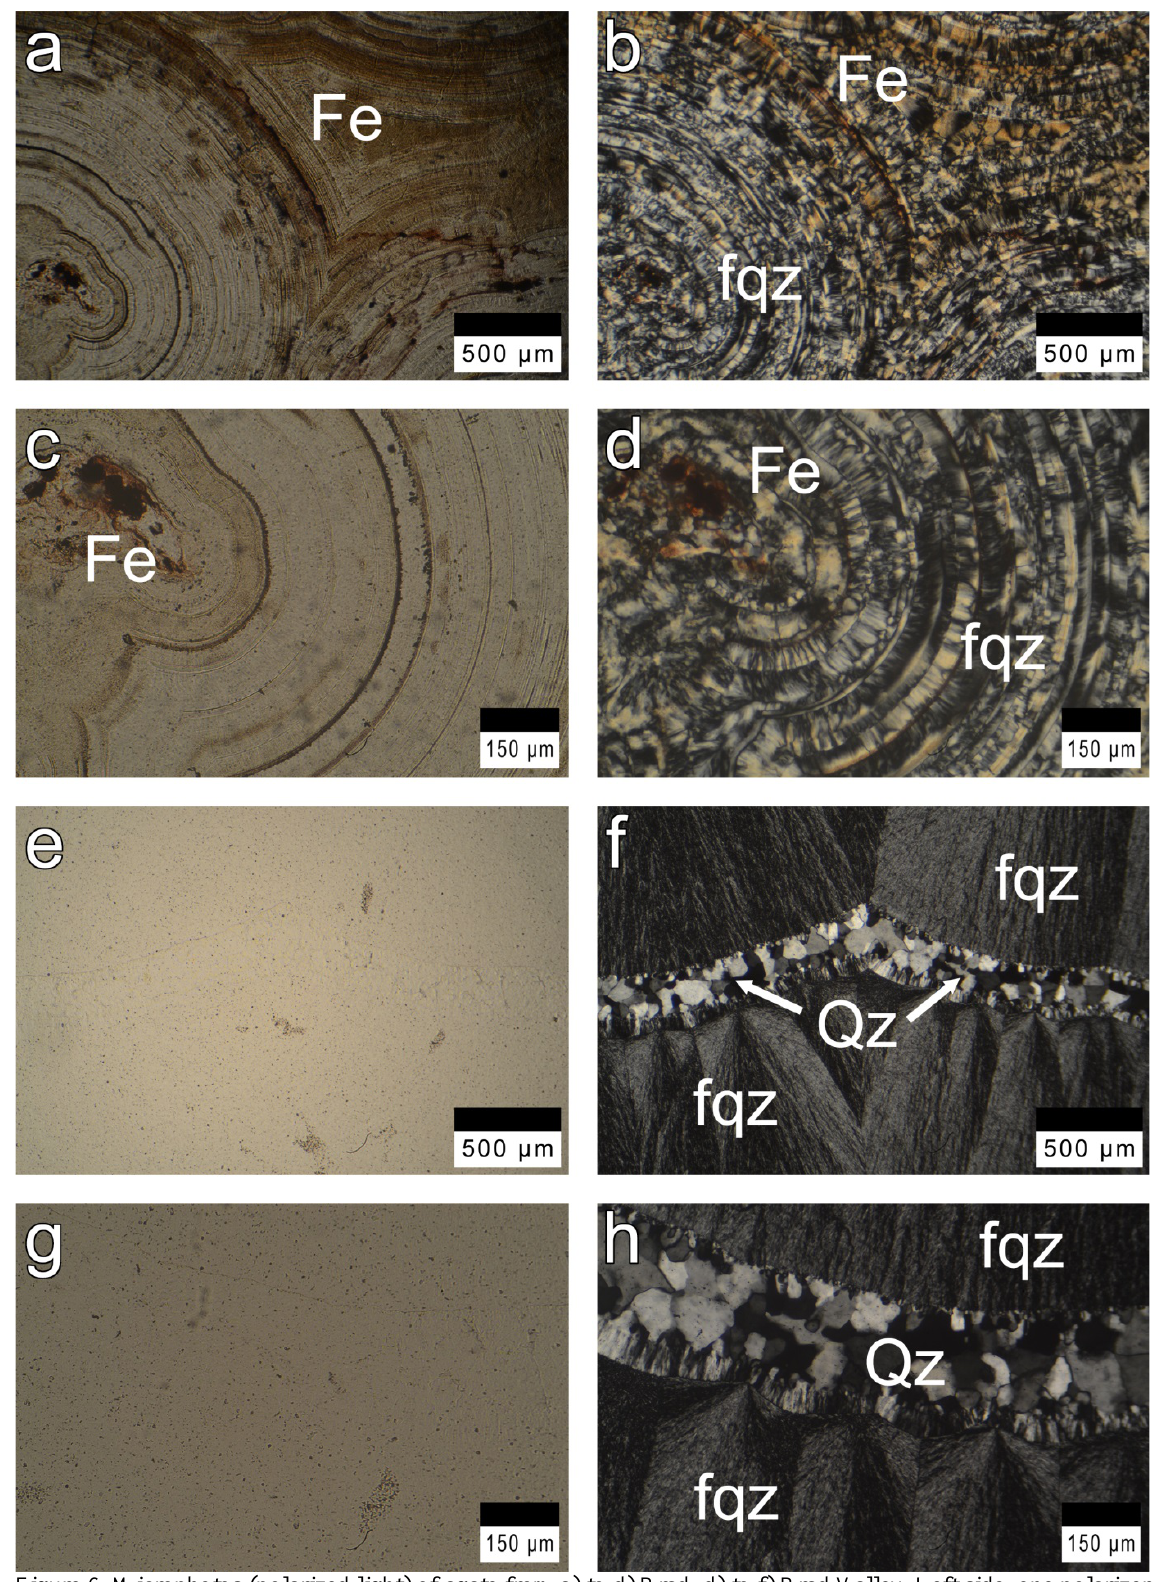
Figure 6. Microphotos (polarized light) of agate from a) to d) Brad; d) to f) Brad Valley. Left side, one polarizer (1P). Right side, the same with crossed polarizers (+P). Abbreviations: Fe for Fe-rich phase, fqz for fibrous quartz, Qz for